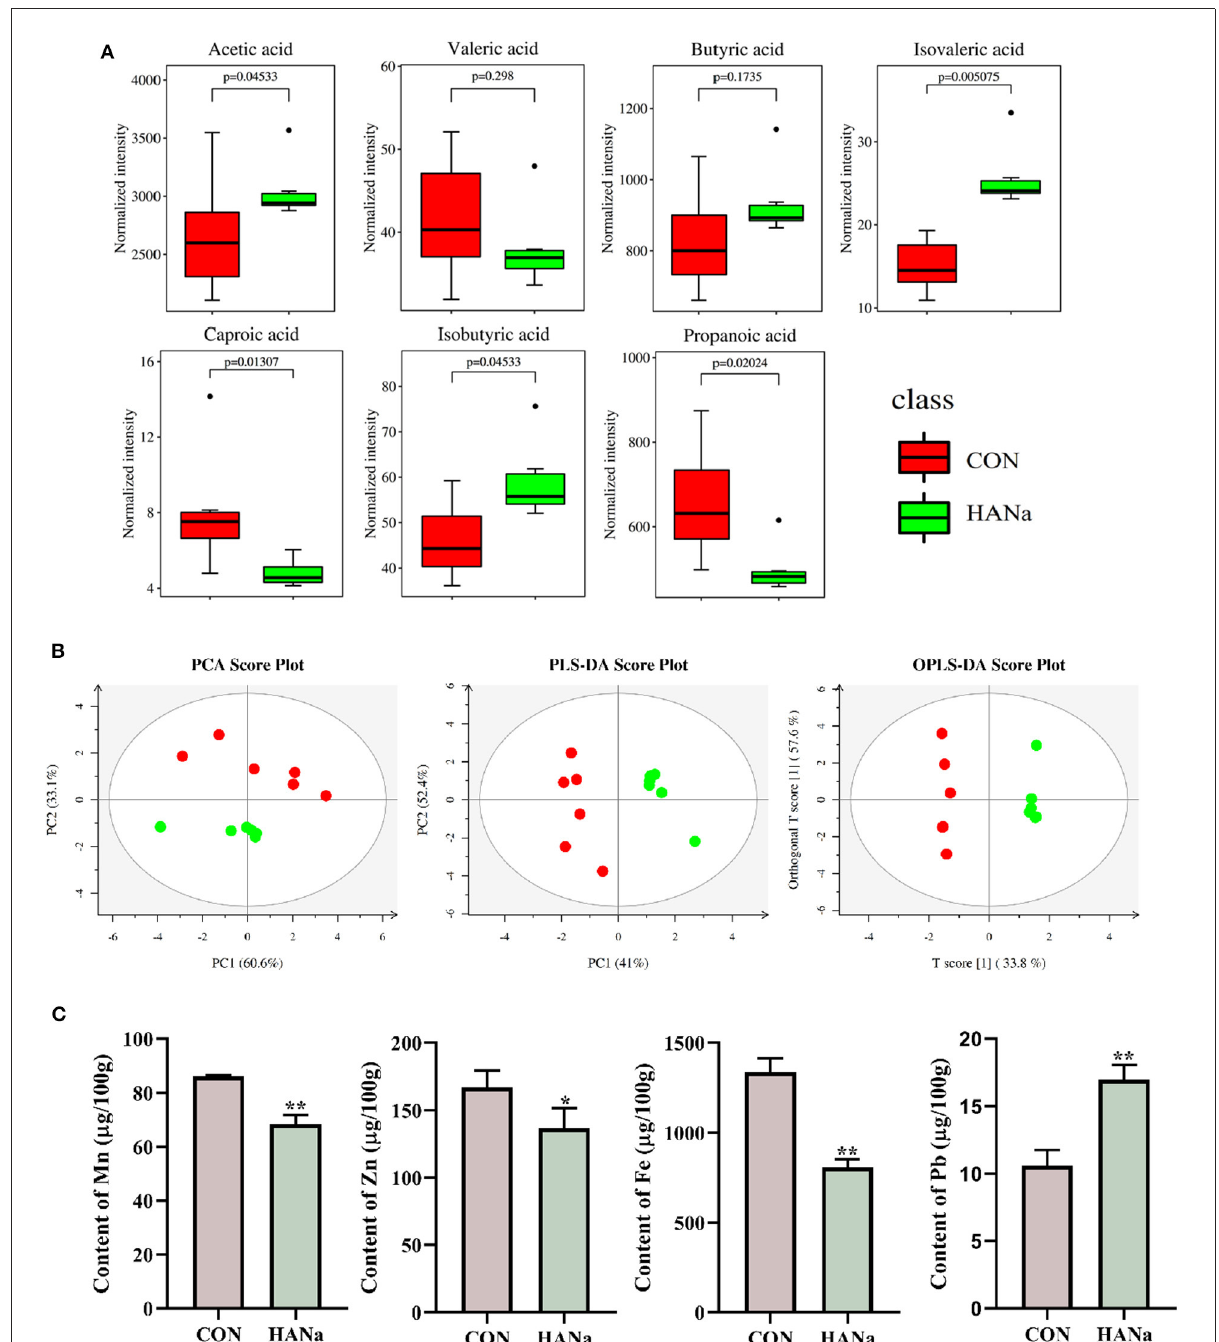
FIGURE2 Effect of sodium humate on the content of short-chain fatty acids and trace elements in the intestinal contents of aged laying hens. (A) Short-chain fatty acid content. (B) Multivariate statistical analysis of short-chain fatty acids (principal component analysis, PCA; partial least squares-discriminant analysis, PLS-DA; orthogonal partial least squares discriminant analysis, OPLS-DA). (C) Contents of trace elements (Mn, Zn, Fe, and Pb). * p ≤ 0.05, ** p ≤